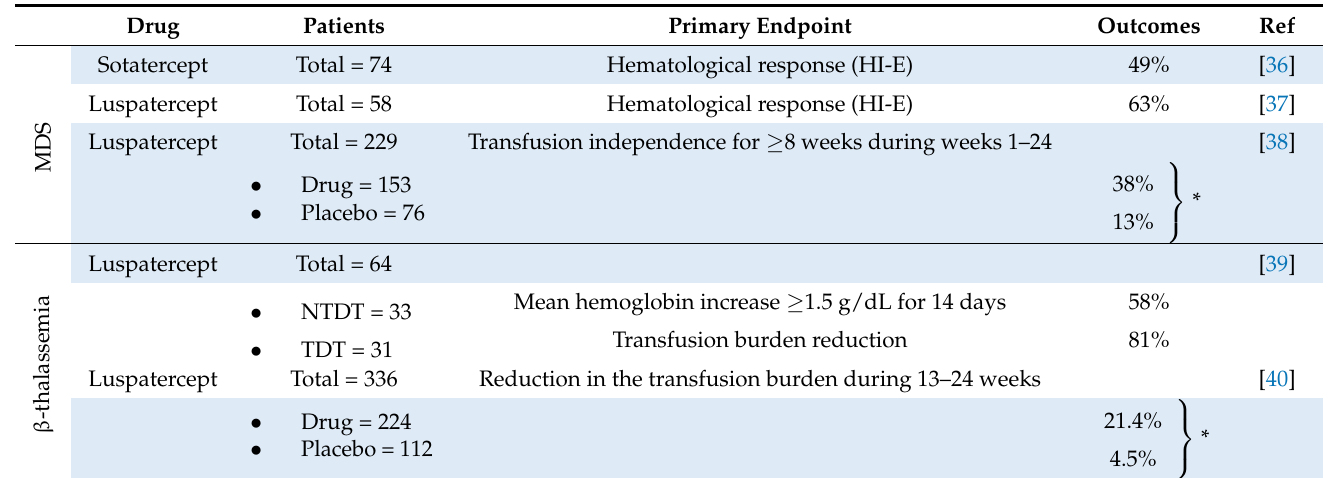
Table 1. Clinical studies using agents that interfere with TGF- β signaling in MDS and β -thalassemia. * p < 0.001. Drug